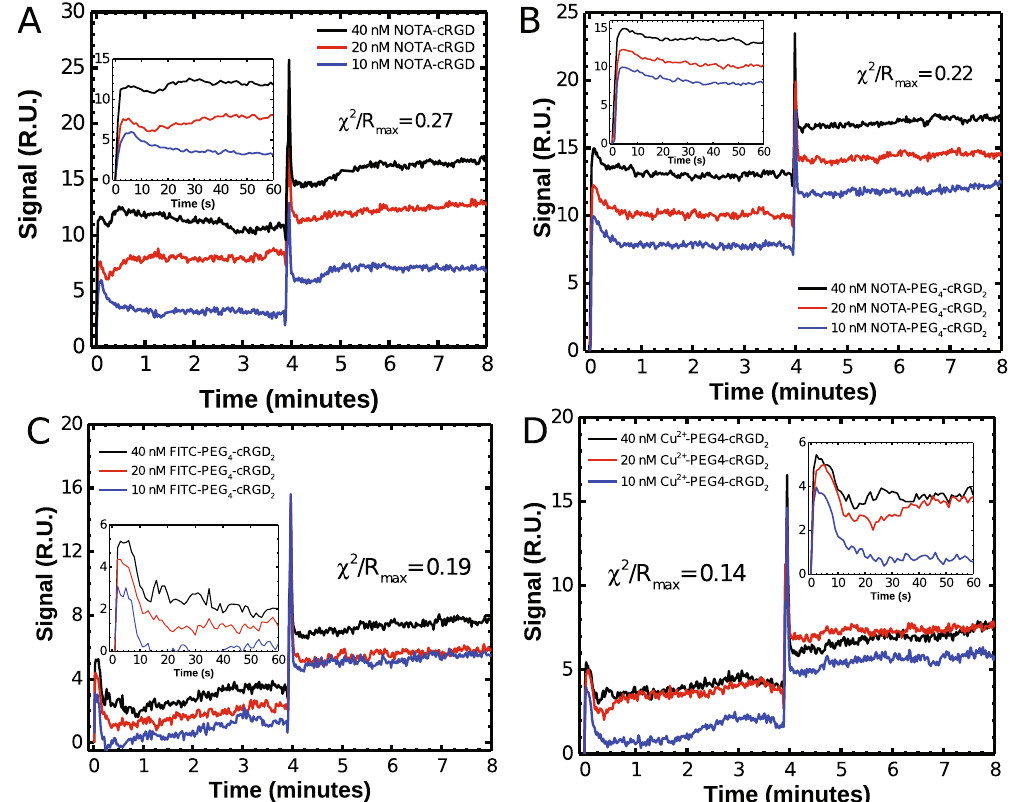
Figure 2. SPR sensograms depicting binding between cRGD ligands and α V β 3 integrin receptor. BIAcore 3000 kinetics studies of interactions between immobilized integrin α V β 3 receptor and ( A ) monomeric cyclic RGD probe (NOTA-cRGD), ( B ) dimeric cyclic RGD (NOTA-PEG 4 -cRGD 2 ) probe, ( C ) cRGD 2 conjugated with FITC (FITC-PEG 4 -cRGD 2 ), and ( D ) NOTA-PEG 4 -cRGD 2 labeled with non-radioactive Cu 2 + . Kinetic studies were performed at a 30 μ L/min flow rate, with a 4 min association followed by a 10 min dissociation period.